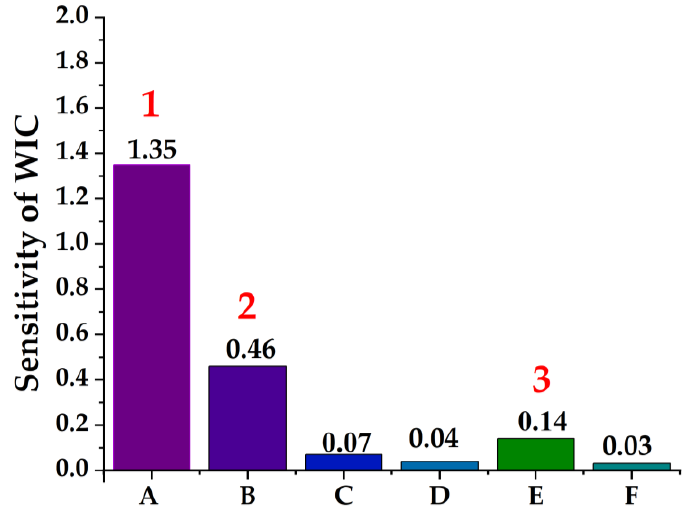
Figure 16. Maximum sensitivity analysis of each parameter: A = Position of the shoulder belt guides; B = Position of the lap belt guides; C = Belt webbing stiffness; D = Initial tension of shoulder belt; E = Seat backrest stiffness; F = Cushion angle.